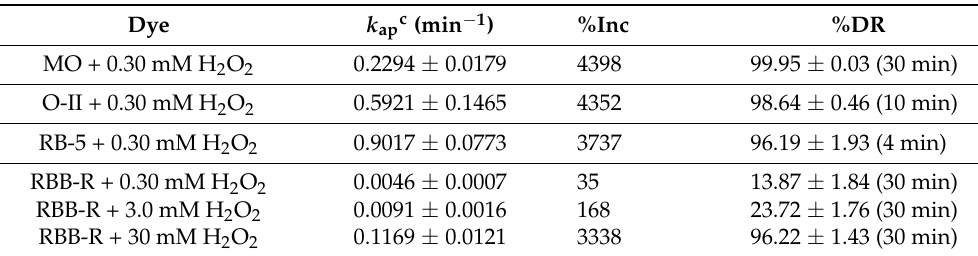
Table 2. Apparent first-order rate constant, percentage of the rate constant when the catalyst is present, and percentage of dye discoloration of the UV + H 2 O 2 AOP of dyes (the standard deviations of at least three independent repetitions are shown). In parentheses, the reaction time necessary to achieve the percentage of dye removal is shown. The fitting of the integrated first-order kinetics resulted in R 2 >